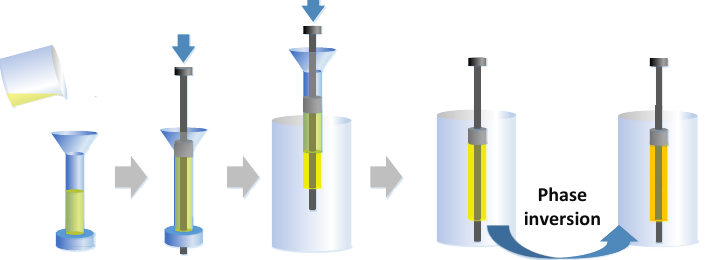
Figure 2. Schematic representation of the support tube preparation process by the phase-inversion casting